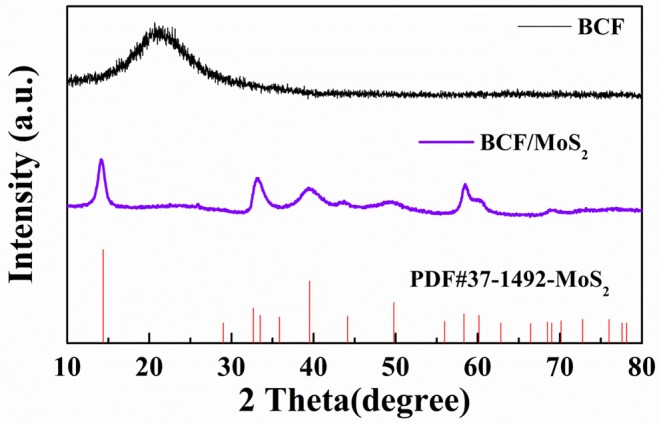
XRD spectra of BCF, BCF/MoS2, and Stand XRD spectrum of MoS2.